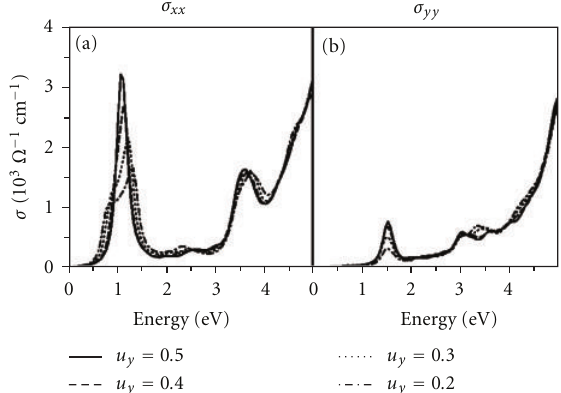
Figure 36: Optical conductivity calculated for di ff erent values of u y which defines the magnetic structure along the b direction